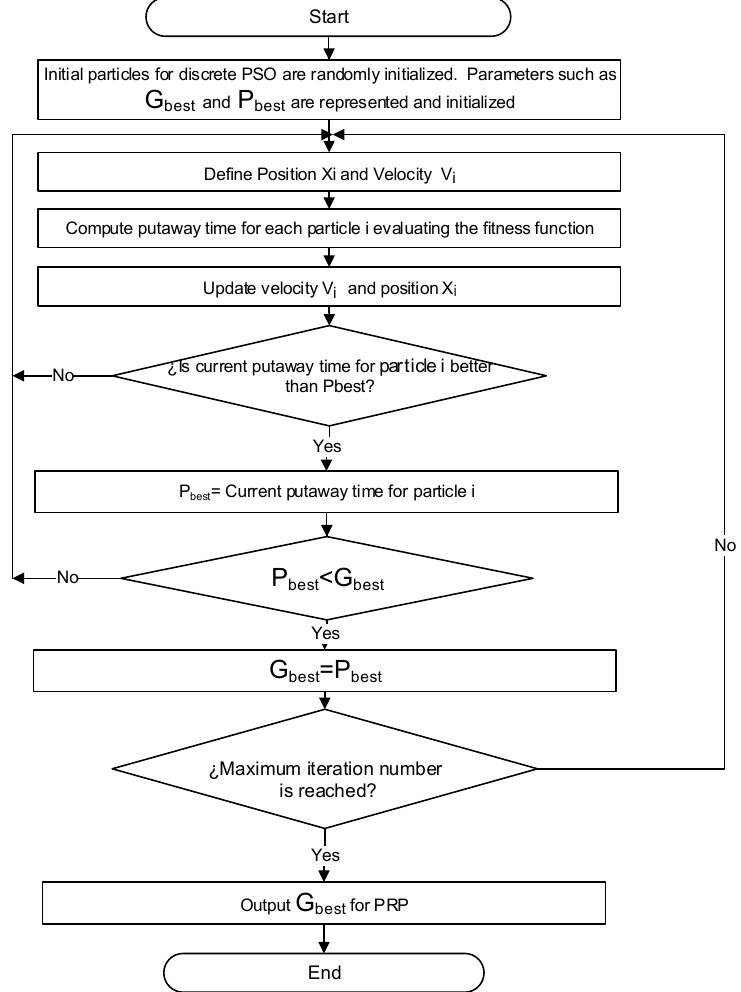
Figure 2. Flowchart of the discrete particle swarm optimization (PSO) for the Put-away Routing Problem (PRP).